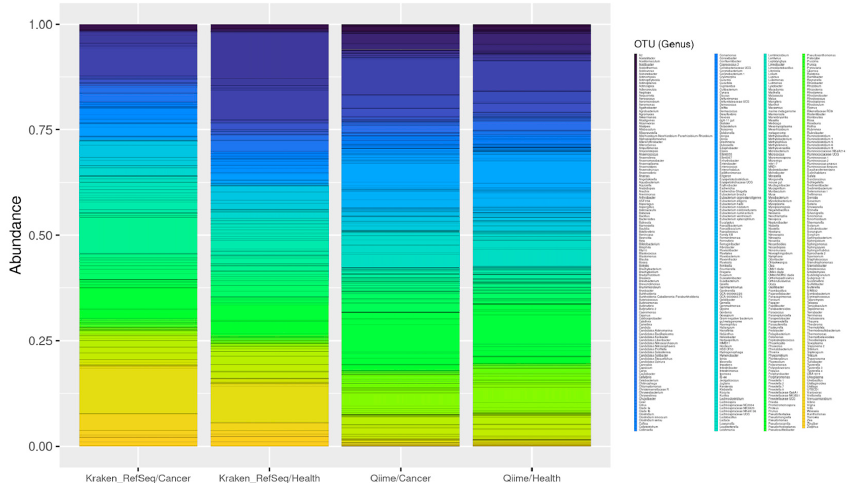
Figure 11 . Number of genera identified for tumour/healthy samples by the Kraken/Bracken (in RNA-Seq) and the QIIME2 (in 16S) pipelines. Barplot showing the number of microorganism genera detected by the Kraken/Bracken pipeline (using RefSeq database) and the QIIME2 pipeline (using SILVA) in an endometrial cancer study by Li C. et al. The list of OTUs in the legend is included in Supplementary Table S6.